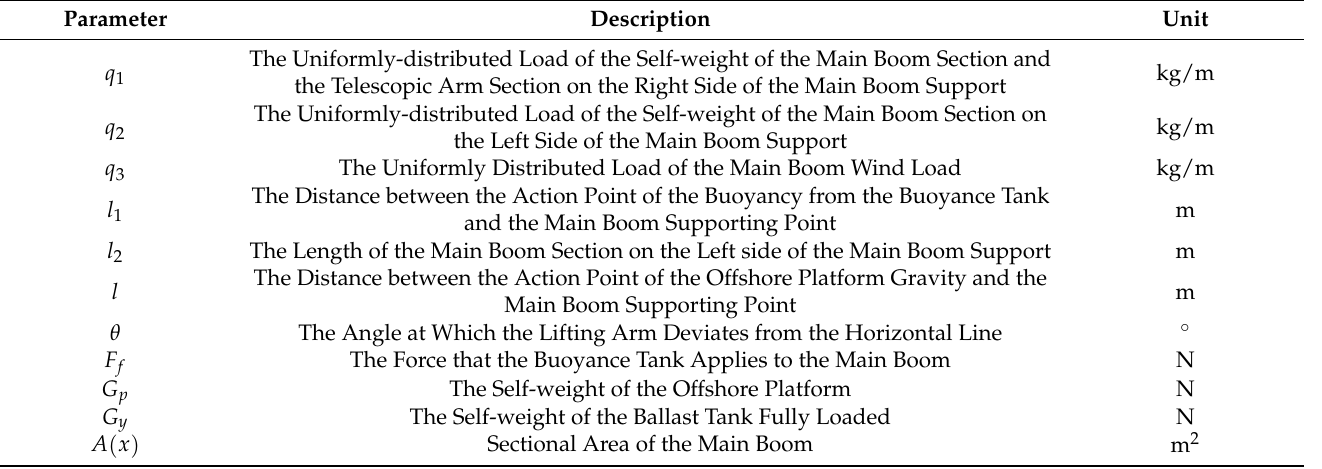
Table 1. Parameters of the Dynamic Model.